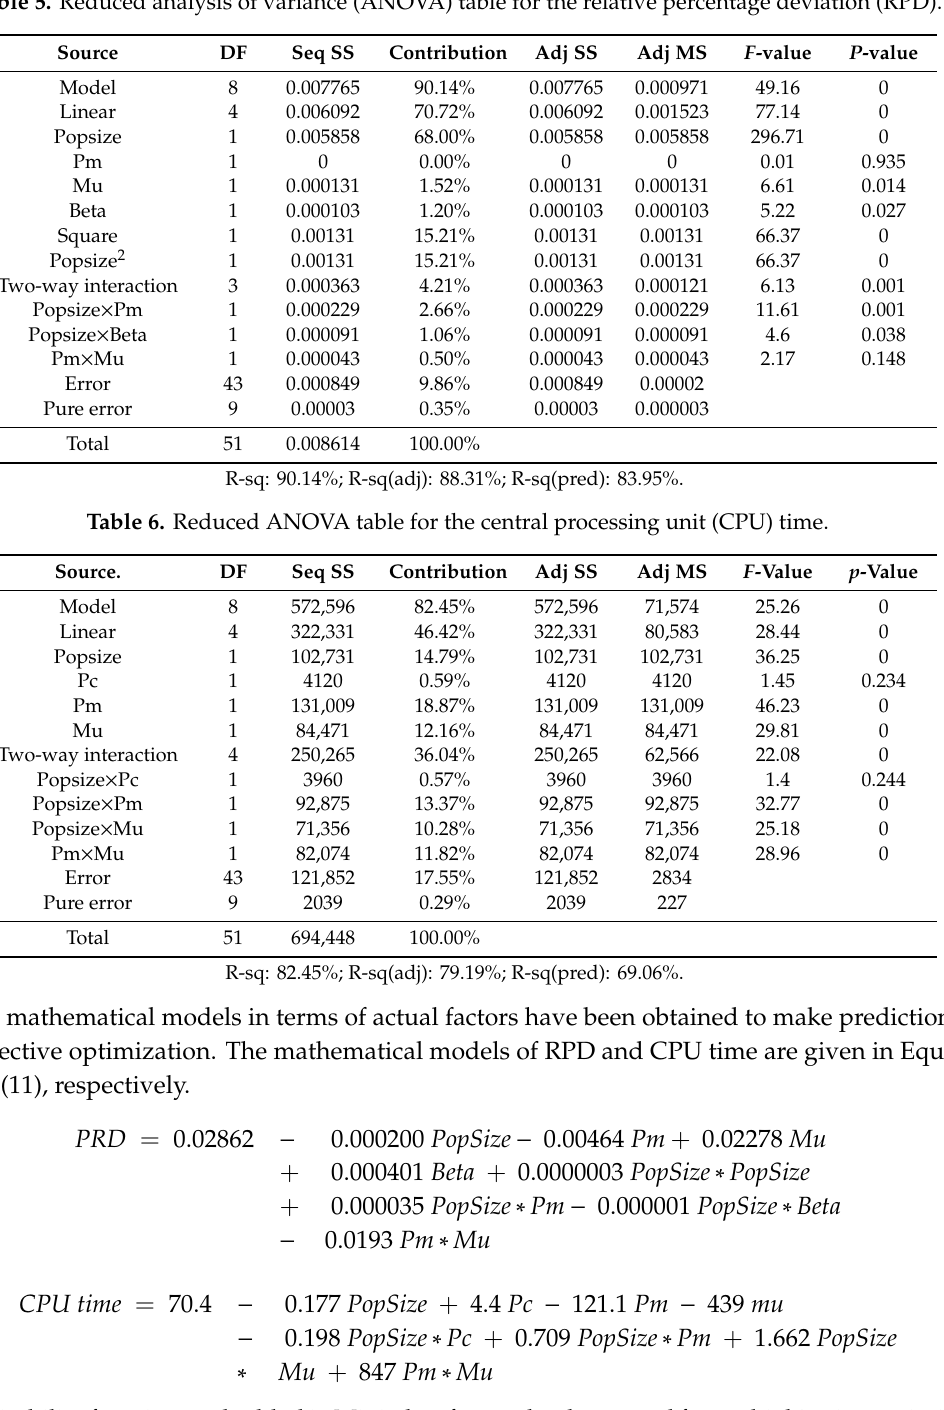
Table 5. Reduced analysis of variance (ANOVA) table for the relative percentage deviation (RPD).